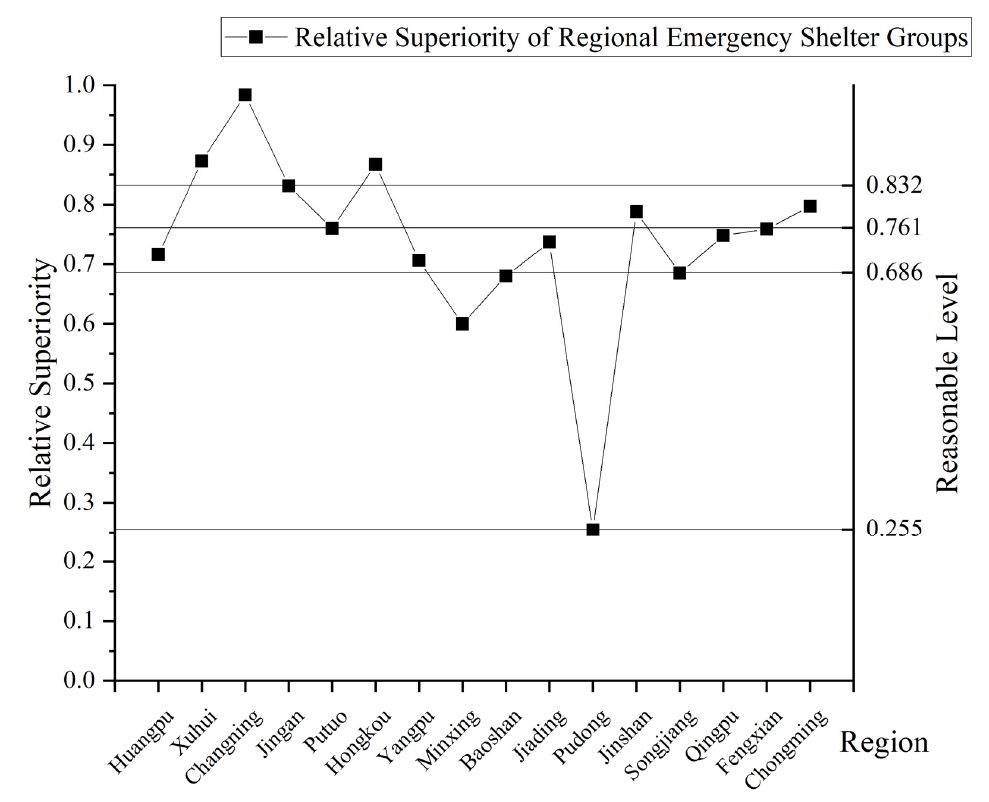
Figure 6. Evaluation results of regional groups of emergency shelters.